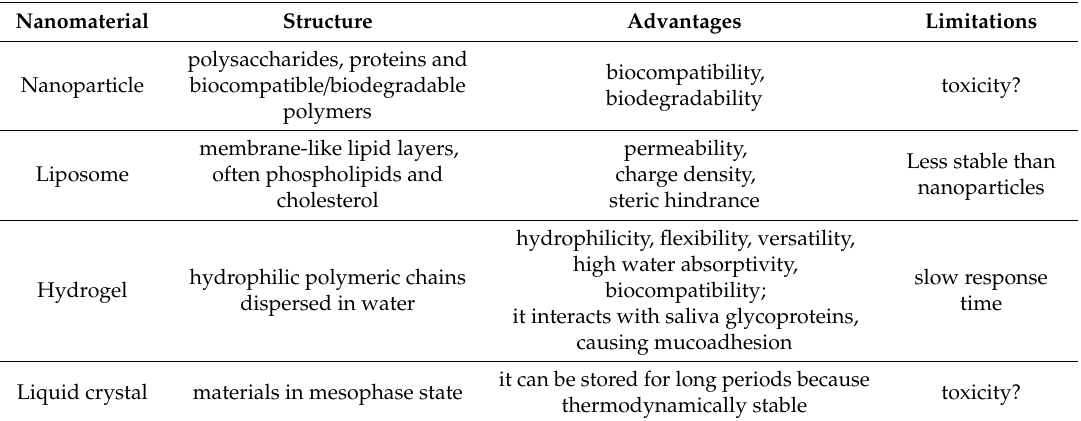
Table 1. Nanocarriers for oral cavity